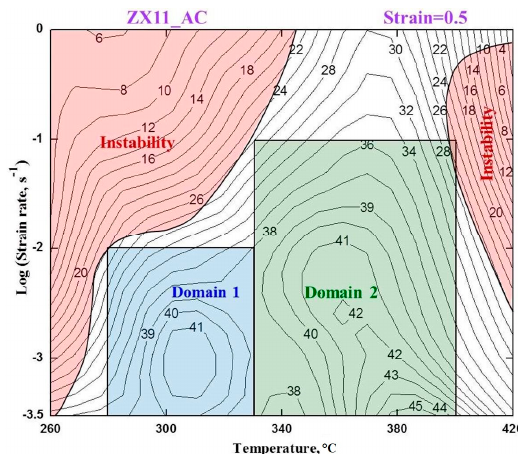
Figure 6. Processing map for ZX11 alloy developed for a strain value of 0.5. The dissipation efficiency values in percent are shown with the contours and the two instability regimes are also superimposed.